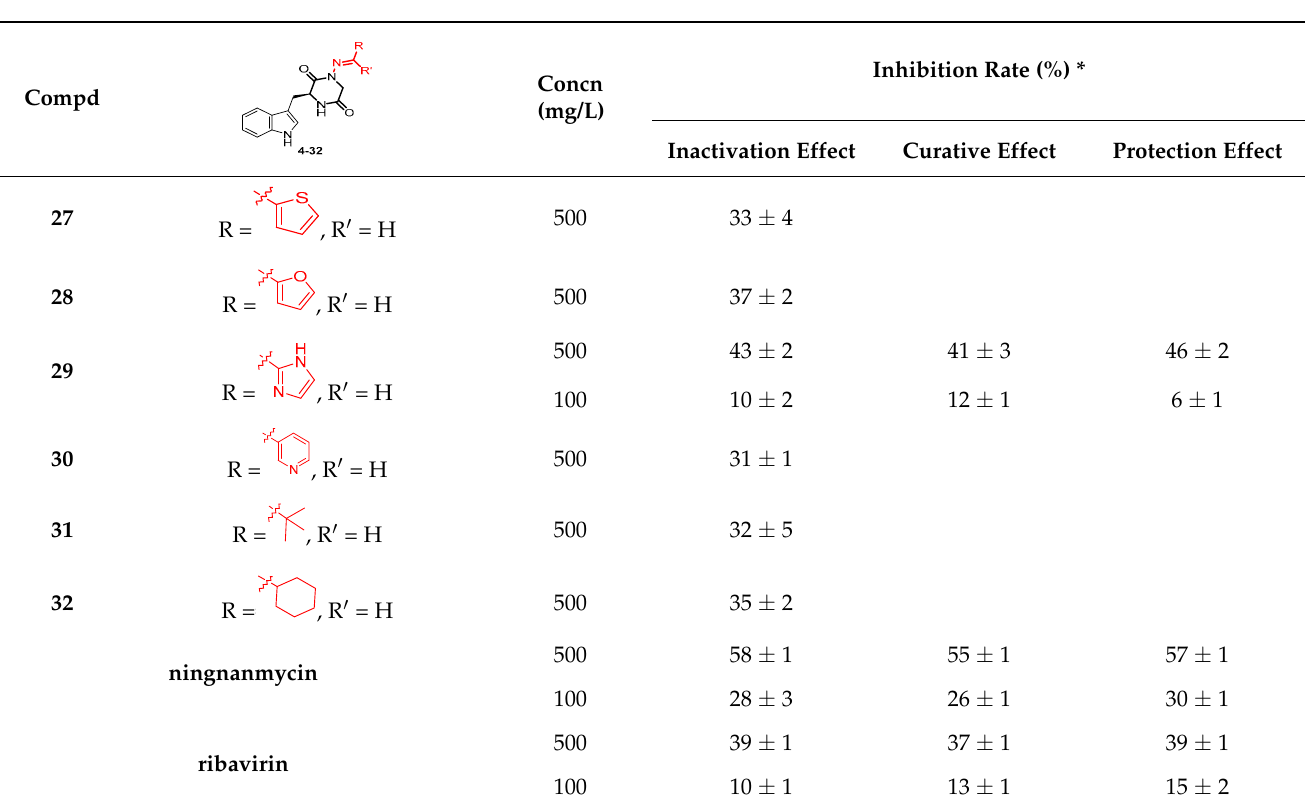
Table 2. Cont. Table 2. In vivo anti-TMV activities of compounds 3 – 32